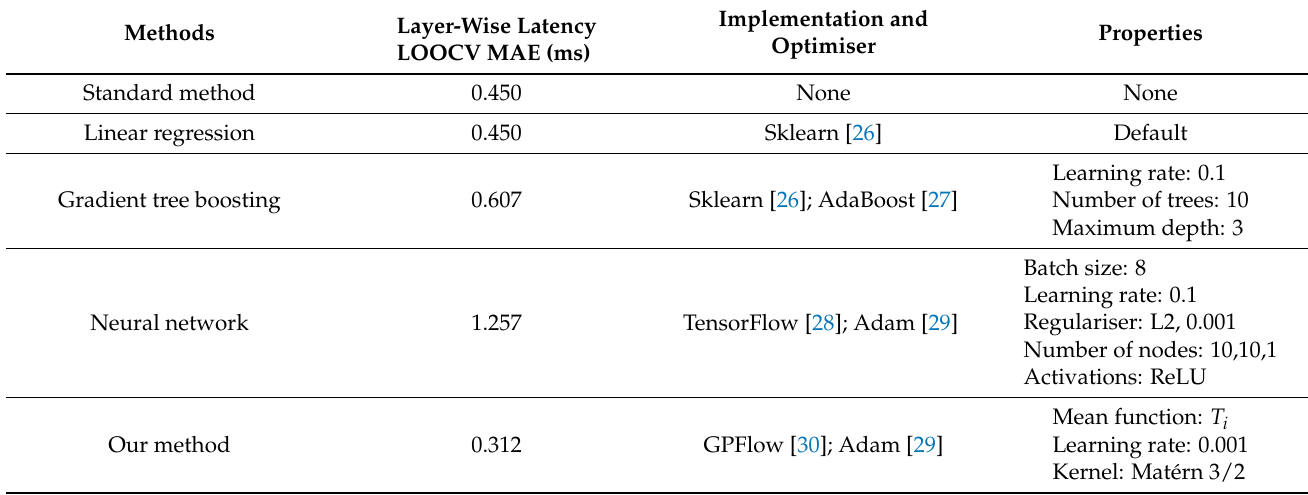
Table 4. Evaluation of layer-wise latency estimation for different methods on the convolutional neural network accelerator on an